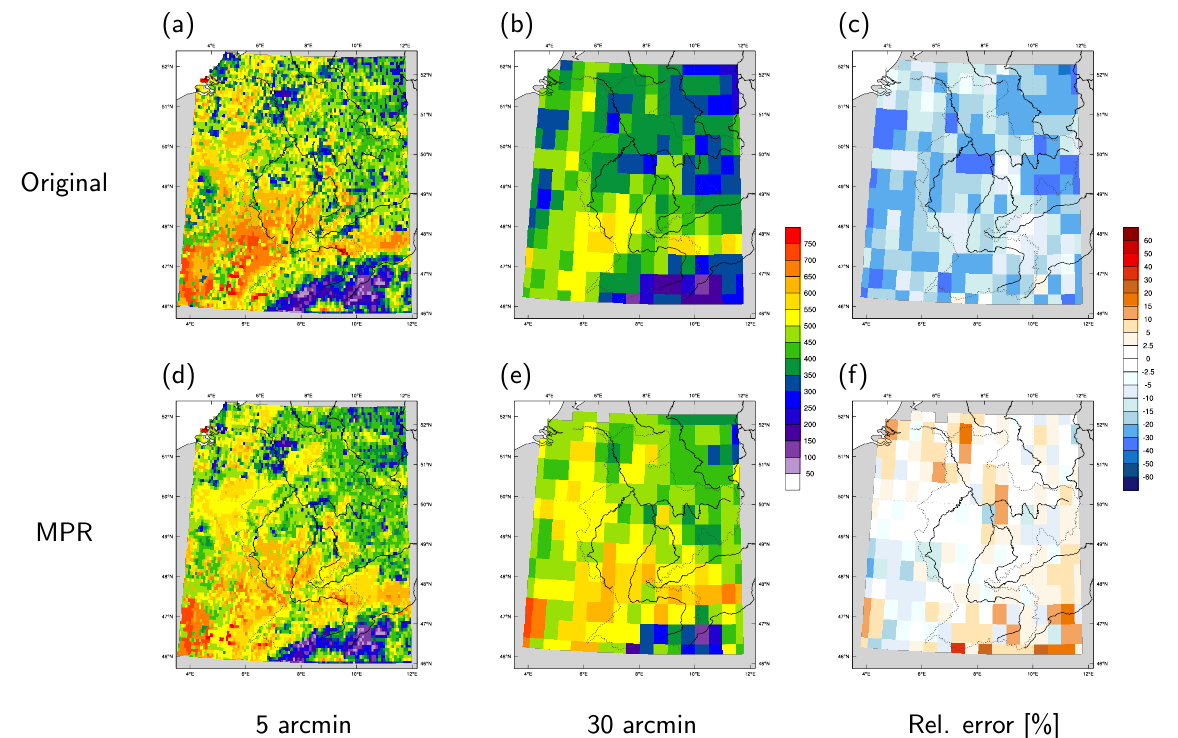
Figure 9. Annual ET fields in 2003 of PCR-GLOBWB before (a, b) and after implementing MPR (c, d) for two spatial resolutions of 5 and 30arcmin. Dotted lines denote the Rhine Basin and the continuous line is the main EU river basin network. The relative errors in percentage of the coarse field estimates with respect to the finer ones are shown in panels (c) and (f) ,